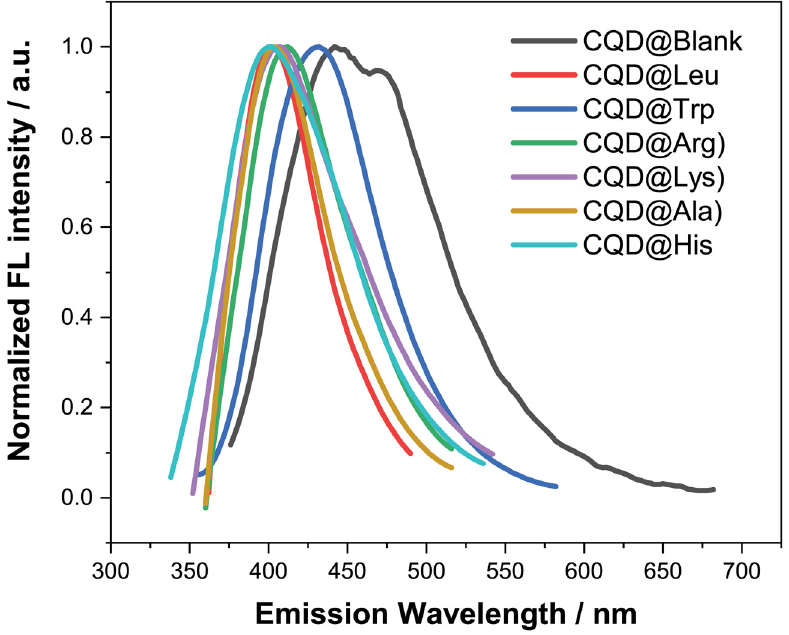
Figure 7. The normalized fluorescence intensities for all selected CQDs recorded at λ EX = 340 nm.